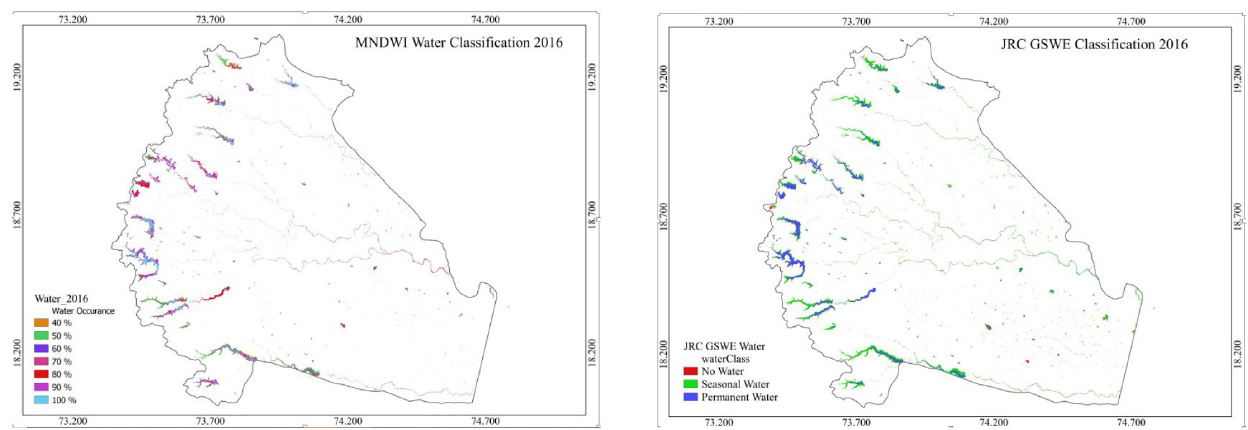
Figure 8. Annual water occurrence by Modified Normalized Difference Water Index (MNDWI) method and Joint Research Centre Global Surface Water Explorer.